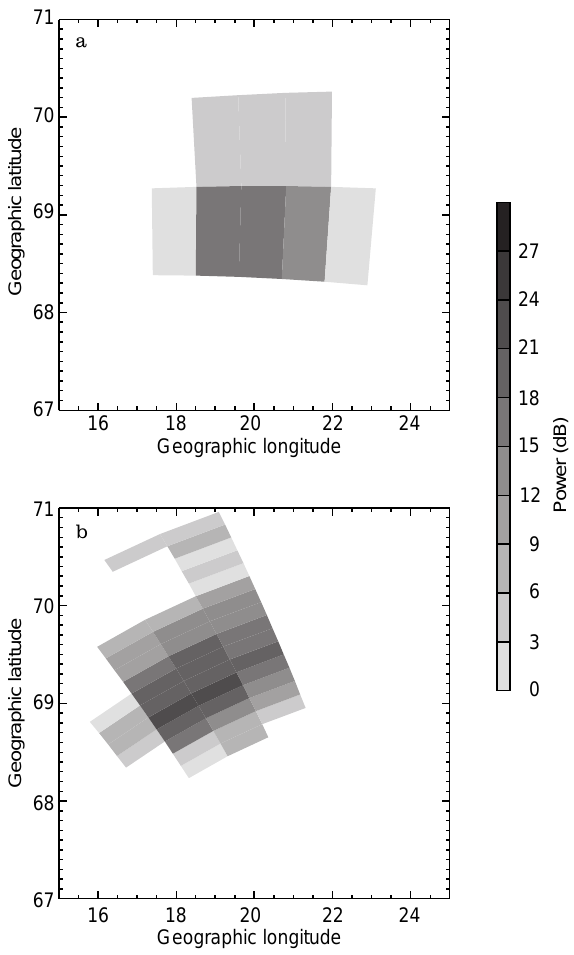
Fig. 11a, b. CUTLASS spatial plots of returned power taken at 1324UT on 24 April 1996, during a heater-on period. a Iceland radar operating at 15MHz in 45km range mode. b Finland radar operating at 12 : 4MHz in 15km